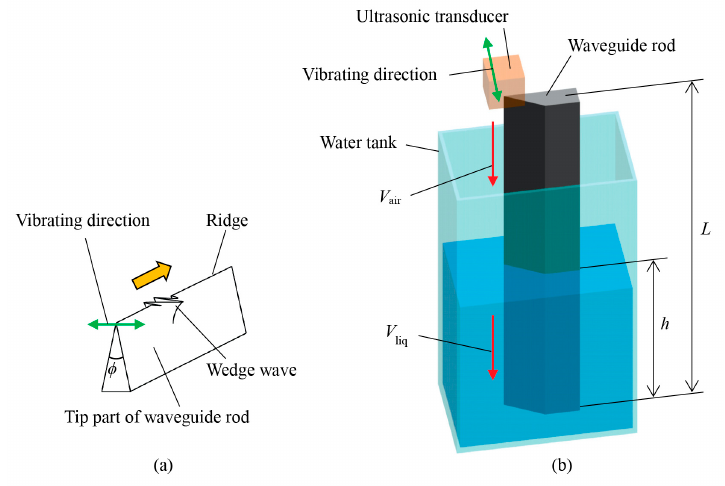
Figure 1. Schematic depiction of liquid-level measurement utilizing wedge wave on waveguide rod. ( a ) Enlarged view of the tip part of the waveguide rod where wedge wave is propagating along the ridge of the wedge. ( b ) Experimental setup. Except for the waveguide, all the components are displayed transparently for visibility. Wedge waves are generated by the ultrasonic transducer. After the launch, wedge waves propagate at V air in the air and V liq in the